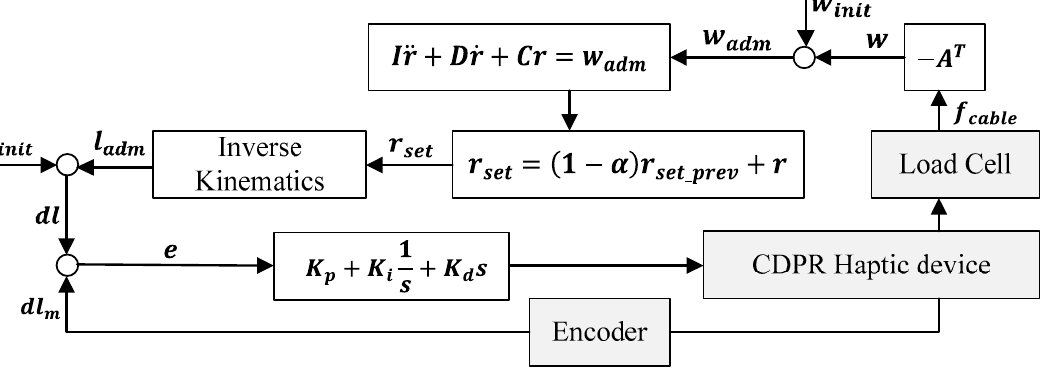
Figure 5. A block diagram of the proposed control algorithm for a haptic CDPR.